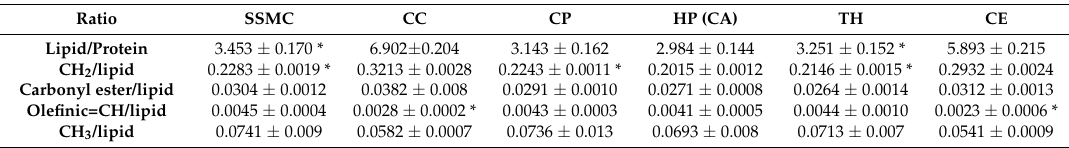
Table 2. Differences in the band-area ratios of various functional groups, within the regions of interest (ROI), of a control healthy rat brain sections.